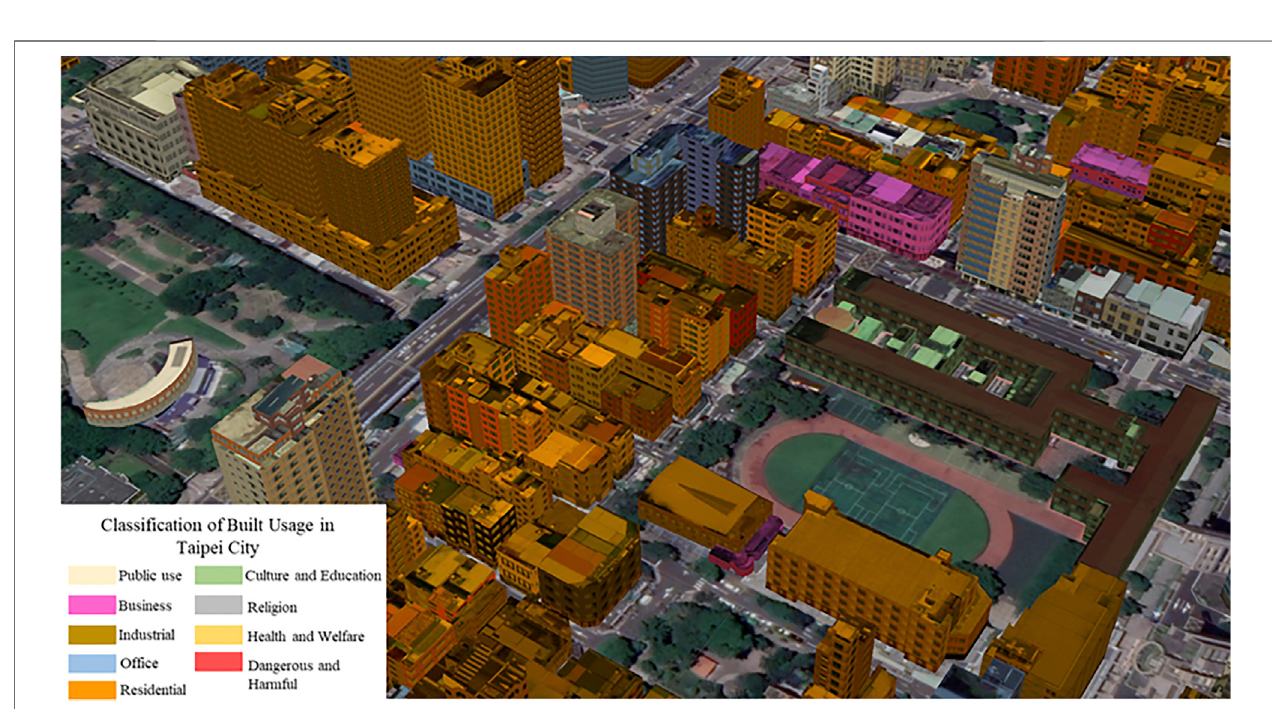
FIGURE 15 | Thematic map of building usage in Taipei City.